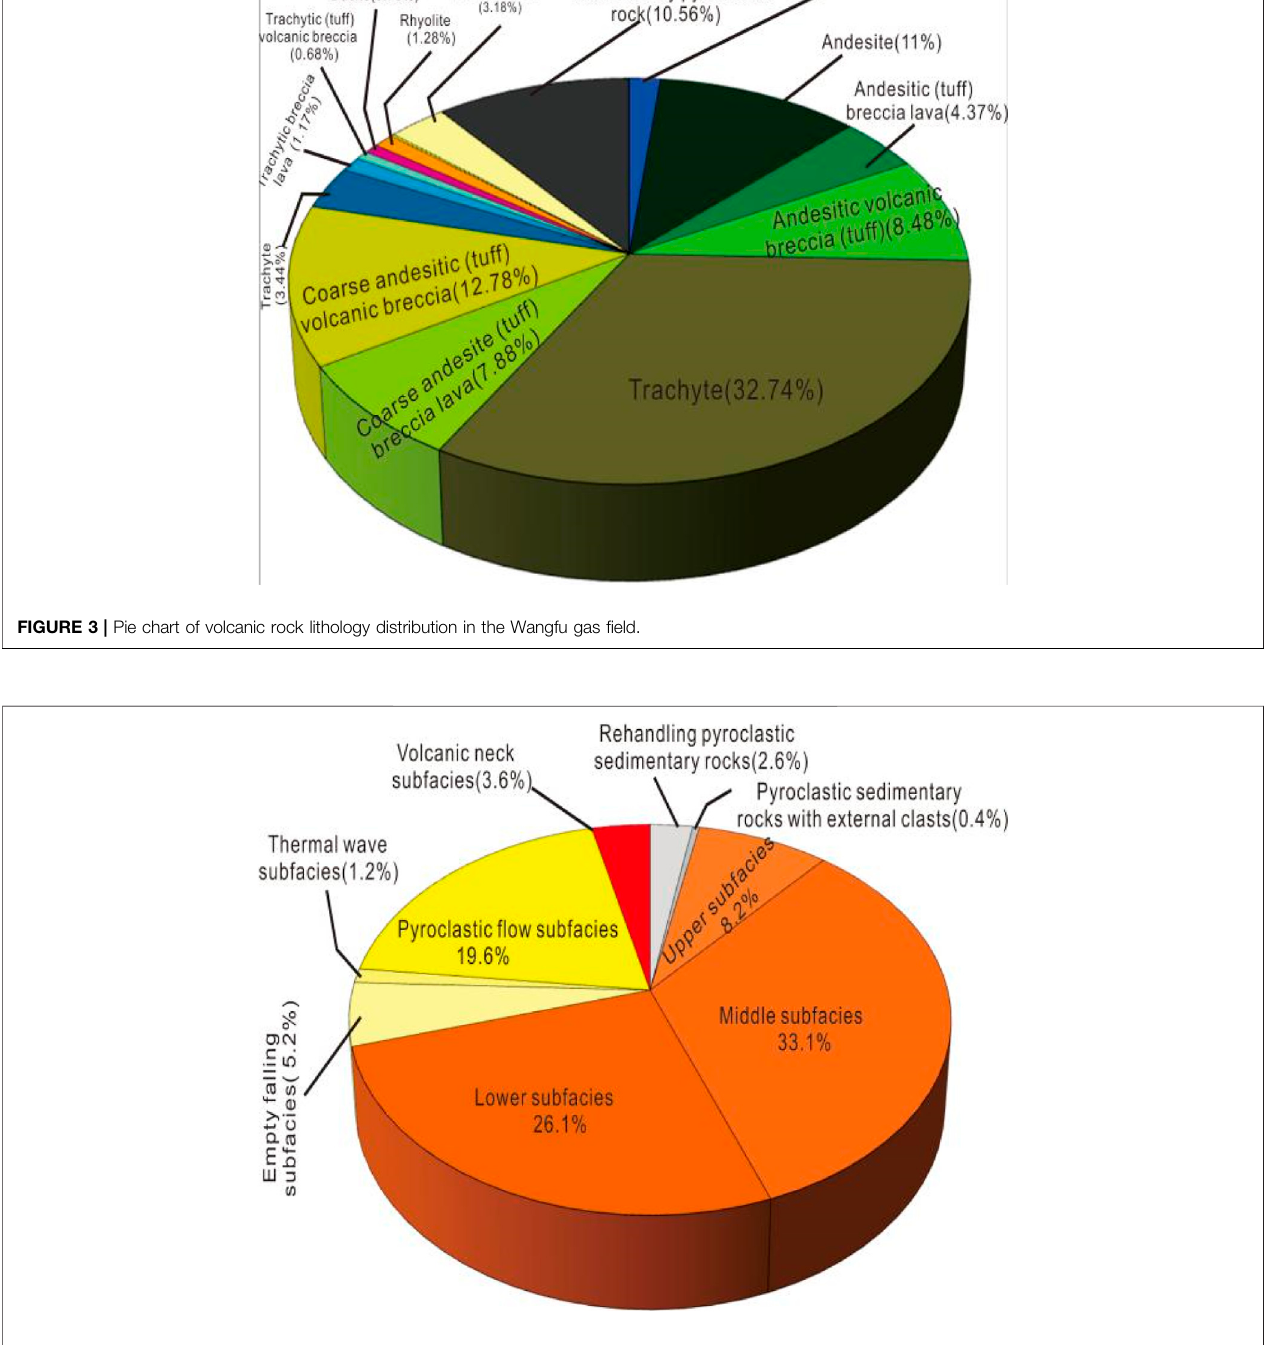
Frontiers in Earth Science |